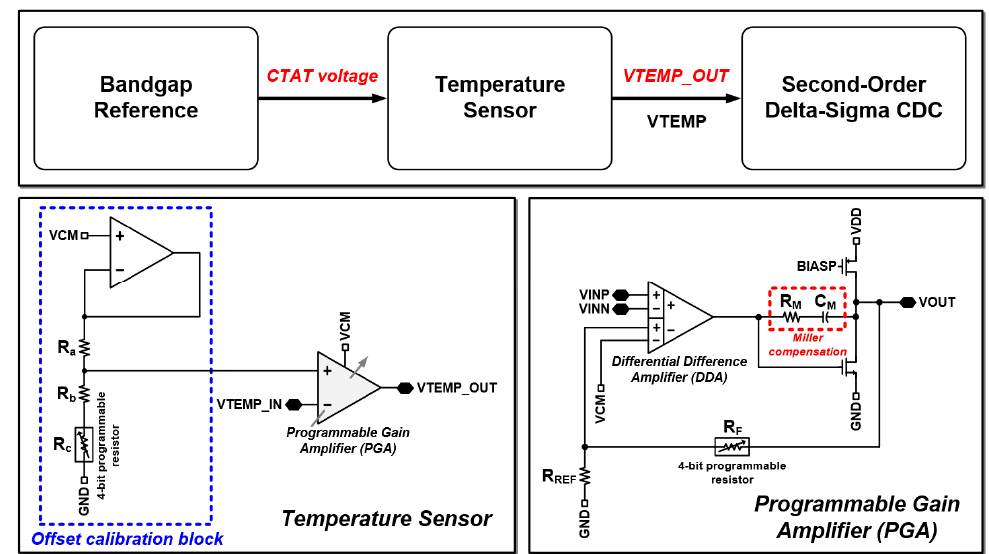
Figure 6. Schematic of fully integrated temperature sensor.